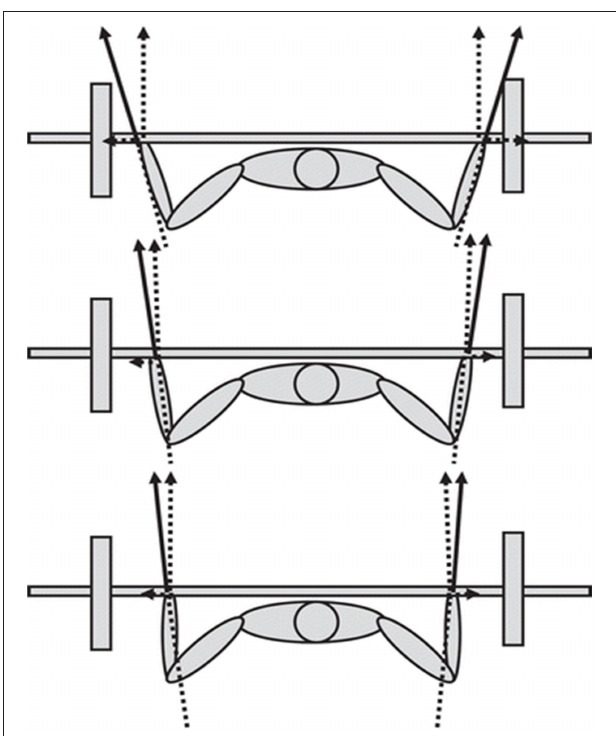
FIGURE 1 | Schematic overview of lateral and vertical force production with same total force production but with different grip widths. Adapted from Gomo and van den Tillaar